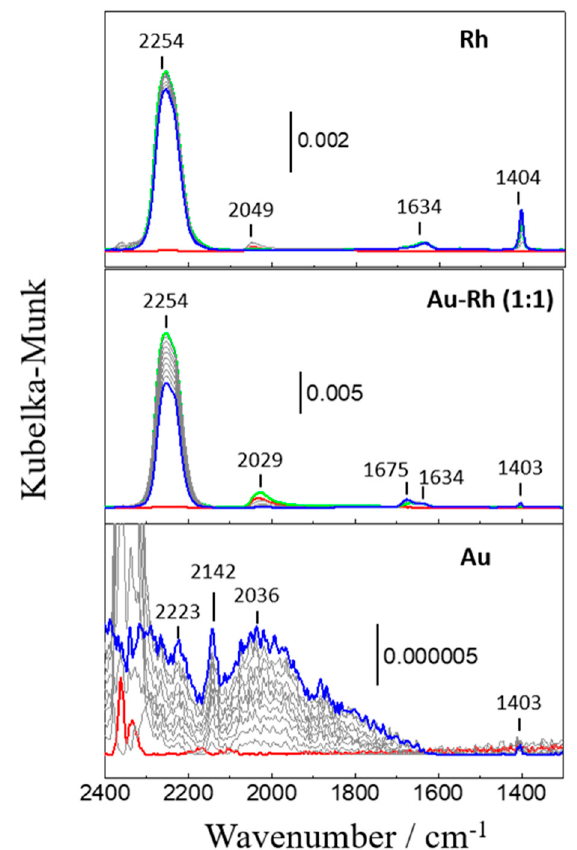
Figure 7. In situ DRIFTS spectra recorded during NO–CO reaction on the Rh/Al 2 O 3 , AuRh(1:1)/Al 2 O 3 , and Au / Al 2 O 3 catalysts at 300 ◦ C for 10 min (from the red line to the blue line at an interval of 1 and Au/Al 2 O 3 catalysts at 300 °C for 10 min (from the red line to the blue line at an interval of 1 min). Gas mixture: 2000 ppm NO, 2000 ppm CO, and He balance; total flow rate: 100 mL/min.